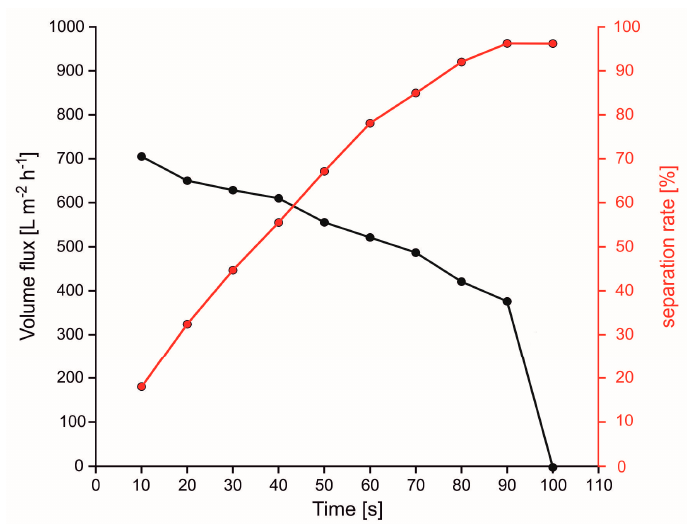
Figure 6. Decreasing separation efficiency (rate) with increasing flux (adapted from [77]).